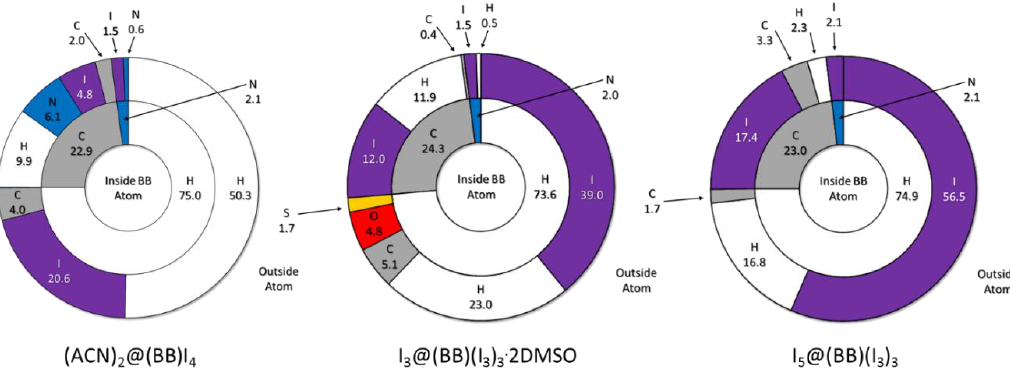
Figure 7. Overview of BB Hirshfeld surface composition for all discussed crystal structures (same data in tabular form are found in Table S3). Inner ring: internal composition of Hirshfeld surface, i.e., a depiction of BB molecular surface; outer ring: closest outer atom, i.e., atom in contact with BB Hirshfeld surface. Color code: white: H; grey: C; blue: N; red: O; yellow: S; violet: I. Data from (ACN) 2 @(BB)I 4 crystal structure taken from [27]. Partly adapted from [27] with permission from John Wiley and Sons.